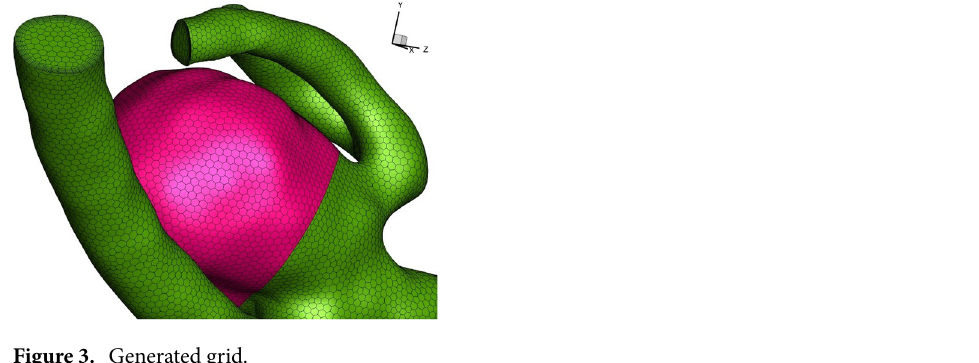
Figure 3. Generated grid.